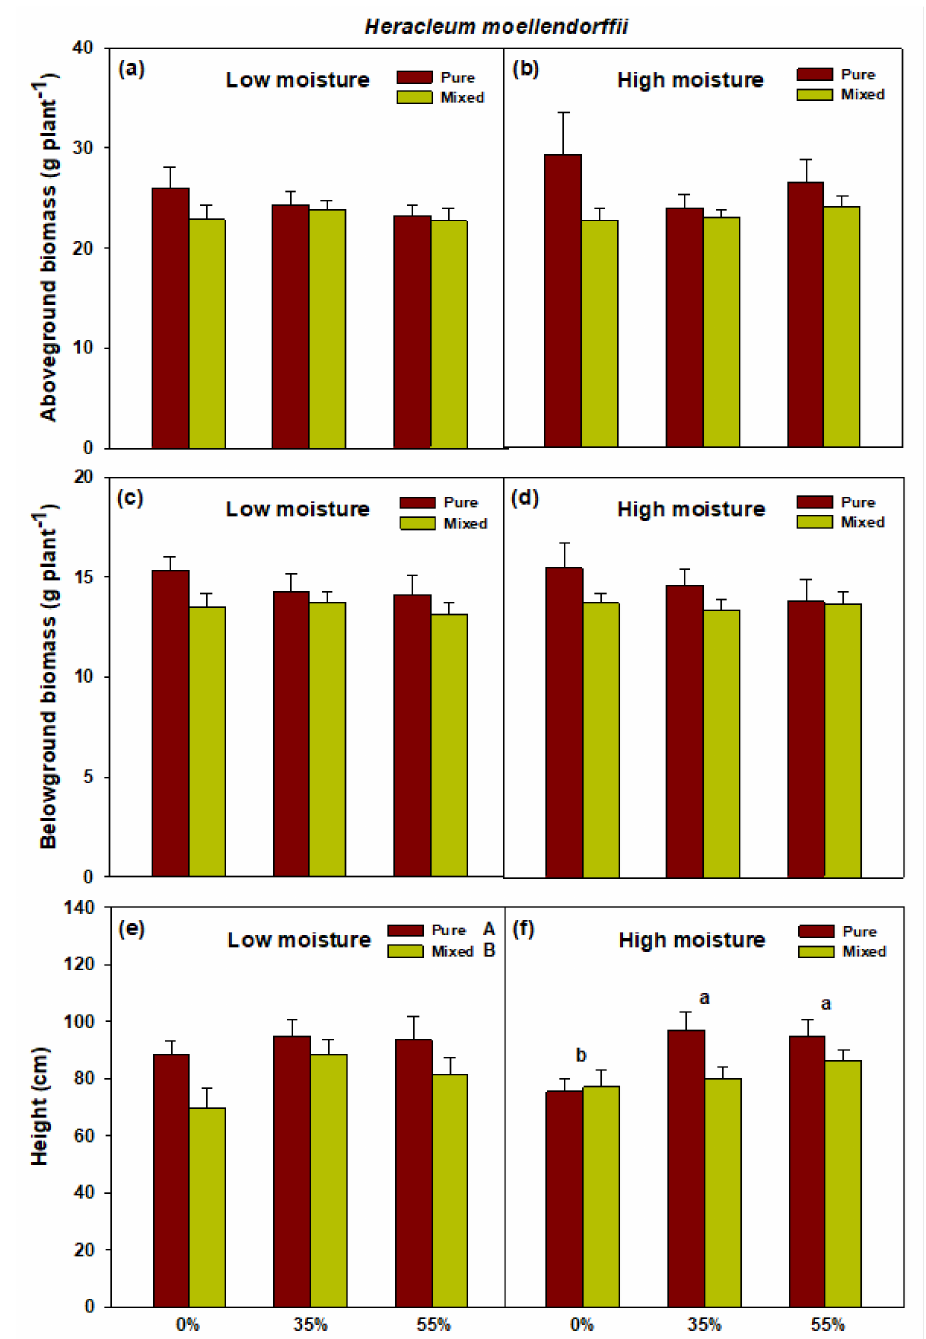
Figure 4. Aboveground biomass ( a , b ), belowground biomass ( c , d ), and height ( e , f ) of pure Heracleum moellendorffii and mixed Heracleum moellendorffii + Adenophora divaricata in different light and soil moisture conditions. Different lowercase and uppercase letters indicate statistical significance across shade treatments and between planting methods, respectively. Vertical bars show standard errors ( n =